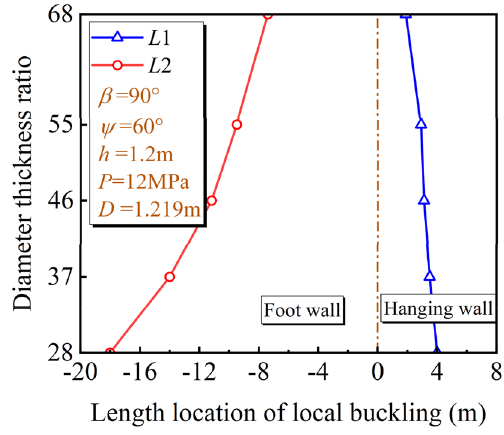
Figure 16. Local buckling location under different D / t.